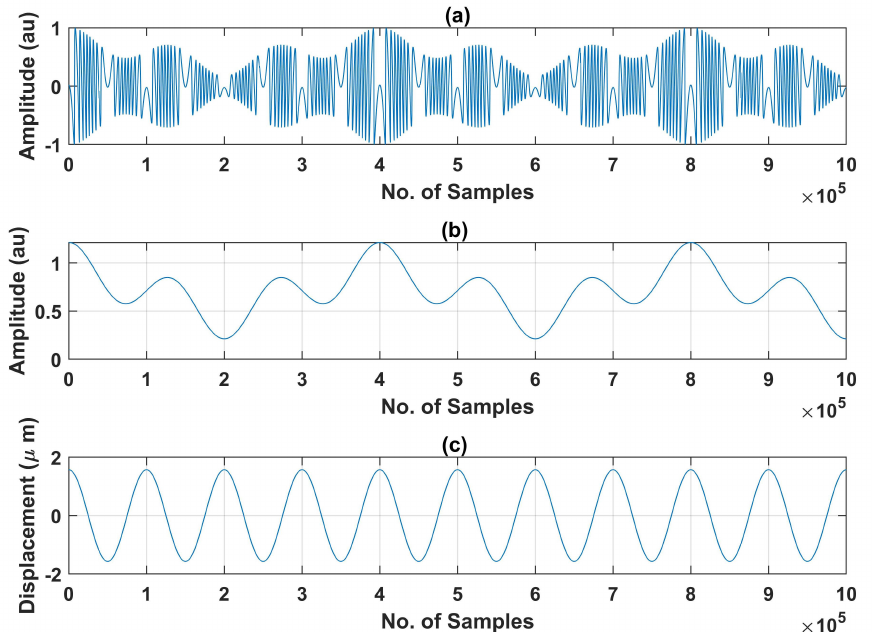
Figure 4. Example of generated SMI signals used in the training dataset: ( a ) generated SMI signal of one second duration with f s of 100 k samples/s corresponding to variable C shown in ( b ) and remote target motion D ( t ) shown in ( c ).